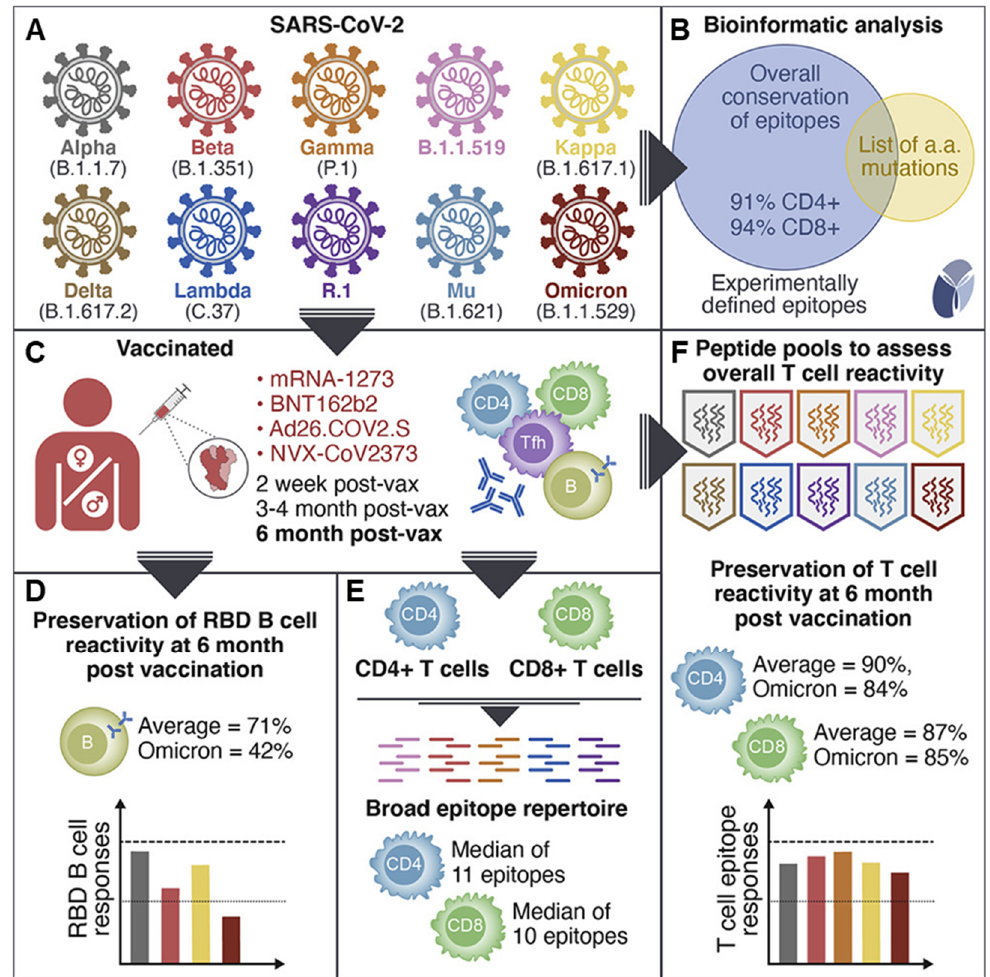
Figure 3. SARS-CoV-2 vaccination induces robust T-cell responses. Compared with decreased B cell responses, T-cell responses are preserved across different vaccine platforms. ( A ) SARS-CoV-2 and emerging variants. ( B ) Prediction of conserved T-cell epitopes. 91% and 94% of CD4 + and CD8 + T-cell epitopes are conserved on average, respectively. ( C ) T-cell responses in donors vaccinated with mRNA-1273, BNT162b2, Ad26.COV2.S, or NVX-CoV2373. ( D ) 71% memory B cells against variants on average are observed, and 42% for Omicron. ( E ) T-cell epitope repertoire analysis revealed a median of 11 and 10 spike epitopes recognized by CD4 + and CD8 + T cells. ( F ) 90% CD4 + (84% against Omicron) and 87% CD8 + (85% against Omicron) of memory T-cell responses were preserved against variants on average. Reproduced with permission from Ref. [110]. Copyright 2022, Elsevier.